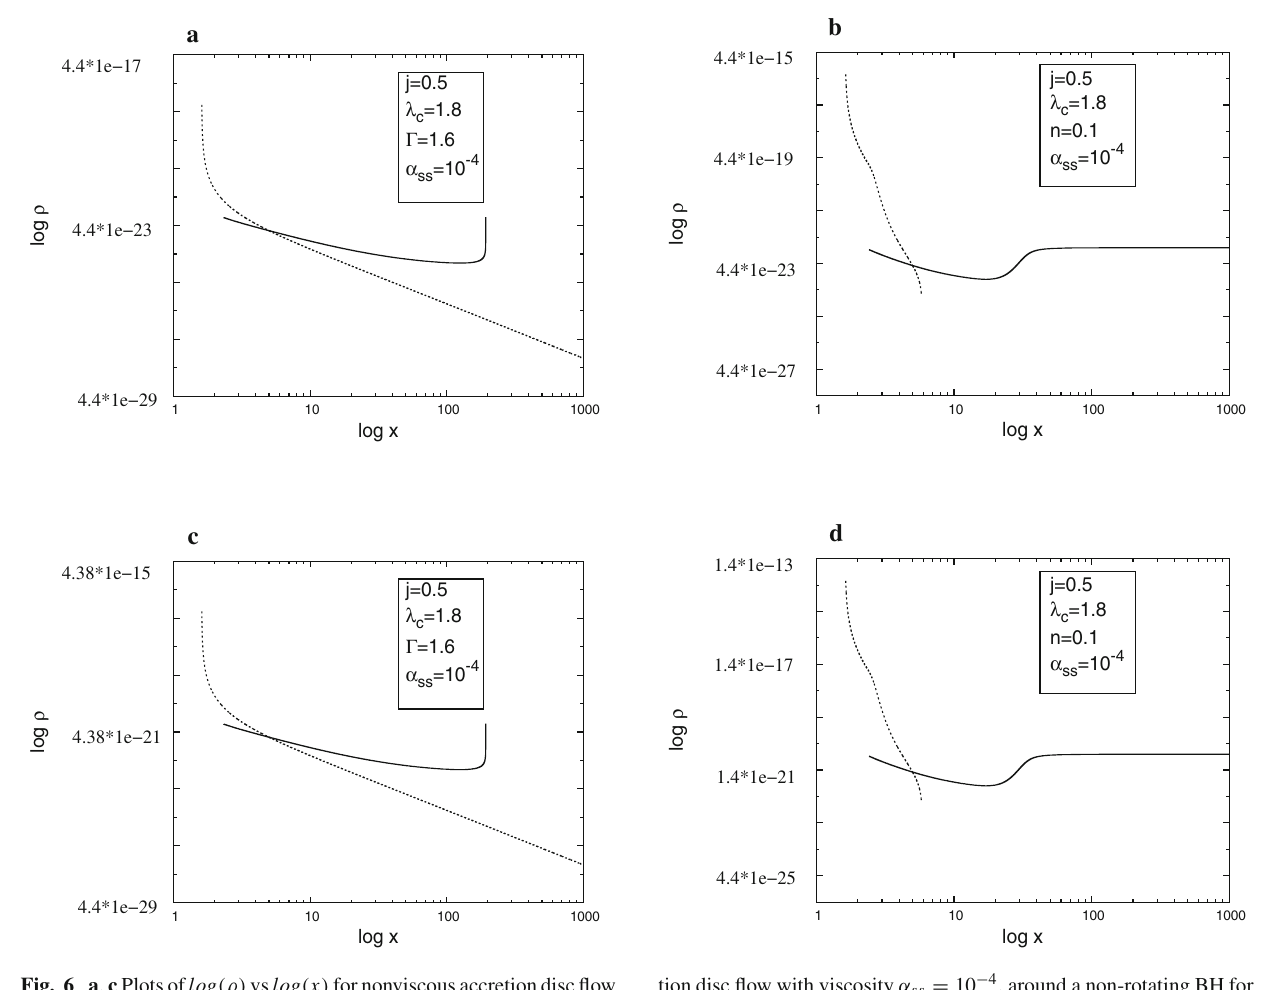
tion disc flow with viscosity α ss = 10 − 4 , around a non-rotating BH for MCG using NFW and Einasto profile respectively. Accretion and wind curves are depicted by solid and dotted lines